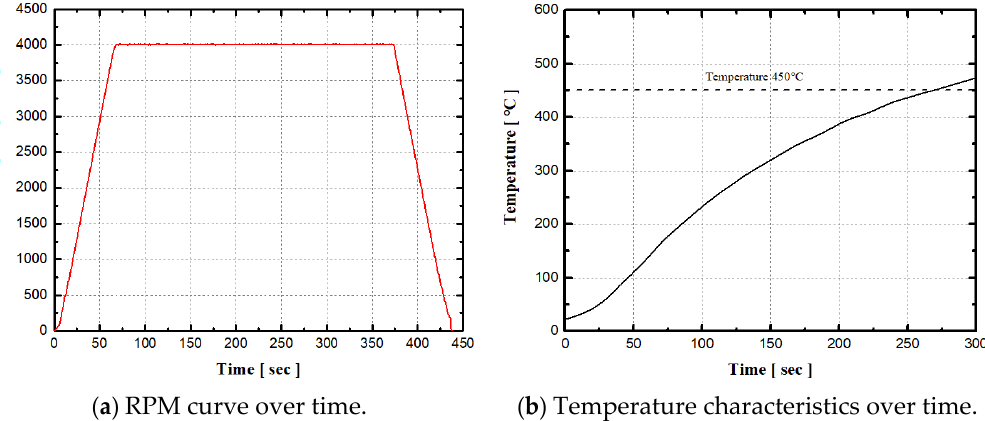
Figure 6. RPM and temperature graph of the base model: ( a ) RPM–time graph; ( b ) temperature– time